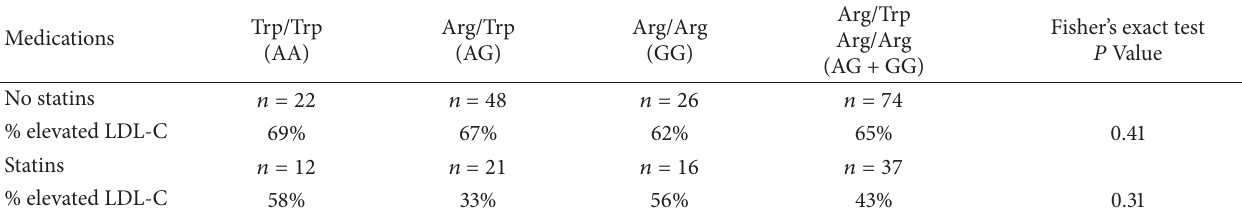
Table 5: Percent of participants with elevated LDL as a function of genotype and statin